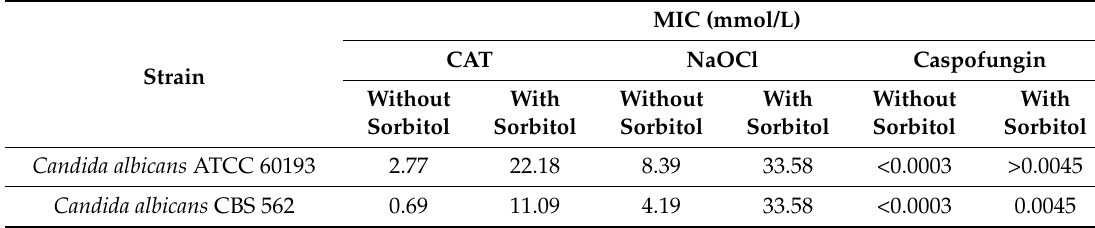
Table 2. Effect of an osmotic protector (sorbitol) on the MIC of chloramine T (CAT), sodium hypochlorite (NaOCl) and caspofungin against C. albicans strains. NaOCl Caspofungin Strain